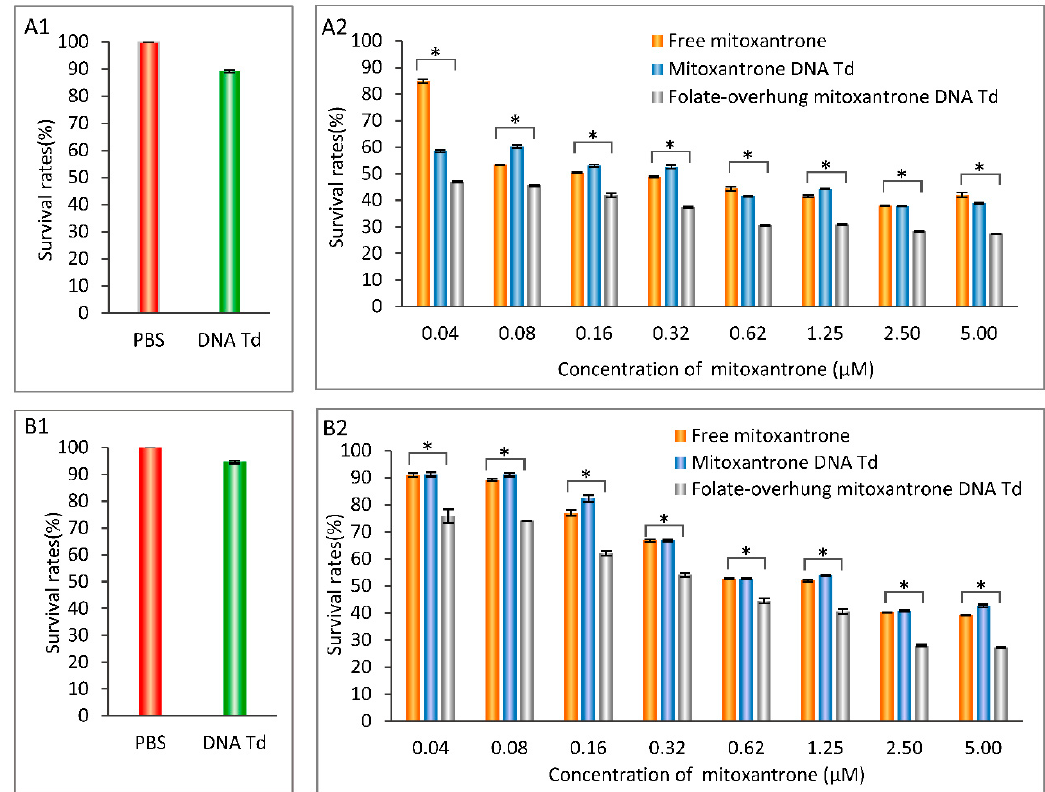
Figure 3. Cytotoxicity of folate-overhung mitoxanthrone DNA tetrahedra in leukemia BALL-1 and K562 cells ( A1 ). Survival rates (%) of the BALL-1 cells after the treatment with varying formulations (PBS, DNA tetrahedra) at 48 h; ( A2 ). Survival rates (%) of the BALL-1 cells after the treatment with varying formulations (free mitoxantrone, mitoxantrone DNA tetrahedra, folate-overhung mitoxantrone DNA tetrahedra) at 48 h; ( B1 ). Survival rates (%) of the K562 cells after the treatment with varying formulations (PBS, DNA tetrahedra) at 48 h; ( B2 ). Survival rates (%) of the K562 cells after treatment with varying formulations (free mitoxantrone, mitoxantrone DNA tetrahedra, folate-overhung mitoxantrone DNA tetrahedra) at 48 h.* signifies p < 0.05.